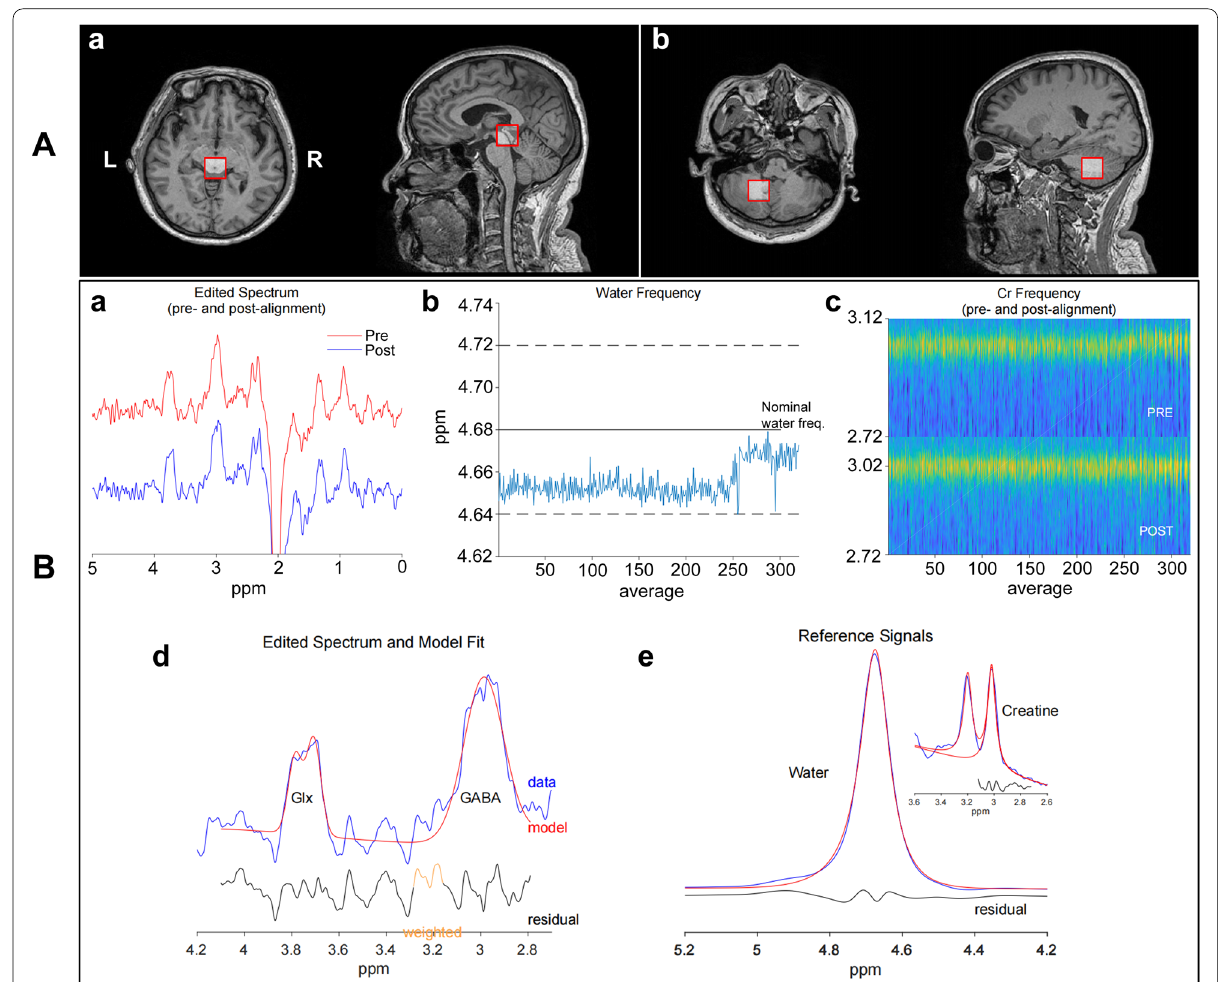
Fig. 1 Magnetic resonance spectroscopy voxel placement and data processing. A This schematic diagram demonstrates the voxel placement in the periaqueductal gray (PAG) ( a ) and dentate nucleus (DN) ( b ). The red lines represent the region of interest. B The processed gamma-aminobutyric acid (GABA)-edited difference spectrum (a ) before frequency and phase correction (red) and ( b ) after (blue). The residual water signal is plotted against time, providing qualitative information about the stability of the experiment The creatine (Cr) signal over the duration of the experiment is shown ( c ). The y-axis represents the frequency (in ppm) of the Cr signal. The modeling of the GABA signal is shown ( d ). The GABA-edited spectrum is shown in blue. The red represents the model of best fit. The residual between these two is shown in black. Modeling of the signal against which GABA is quantified is shown ( e ). Data are shown in blue. Models are shown in red. Residuals are shown in black. L, left; R,